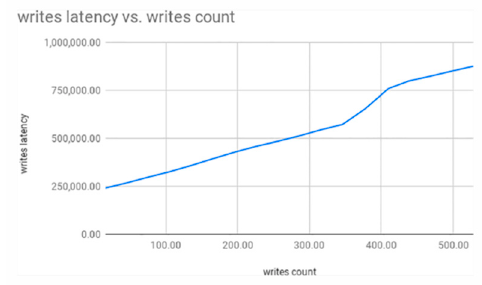
Figure 14. Reads latency curve versus the command operations count.